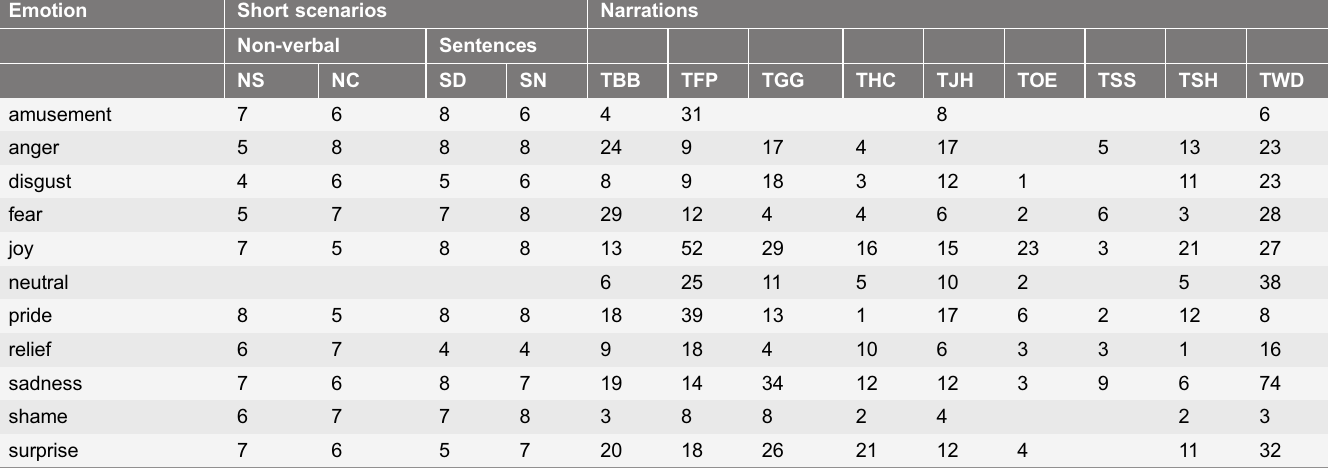
Table 4. Frequencies in the final set of motion sequences across intended emotion categories and acting tasks. Emotion